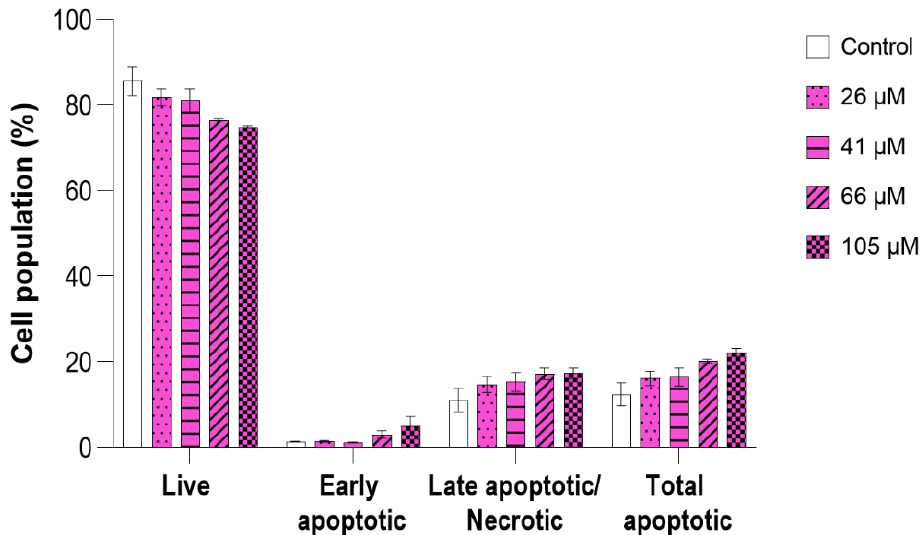
Figure 12. The effect of peptidomimetic 37 on apoptosis of HeLa cells. Cells were treated with four different concentrations of the tested compound (26 µM, 44 µM, 61 µM, and 105 µM) for 24 h. Bar graphs present the percentage of different cell subpopulations: live cells, early apoptotic cells, late apoptotic, and necrotic cells. Total apoptotic cells are the sum of the percentages of early apoptotic and late apoptotic/necrotic cells. Values are presented as mean ± SEM from two independent experiments.